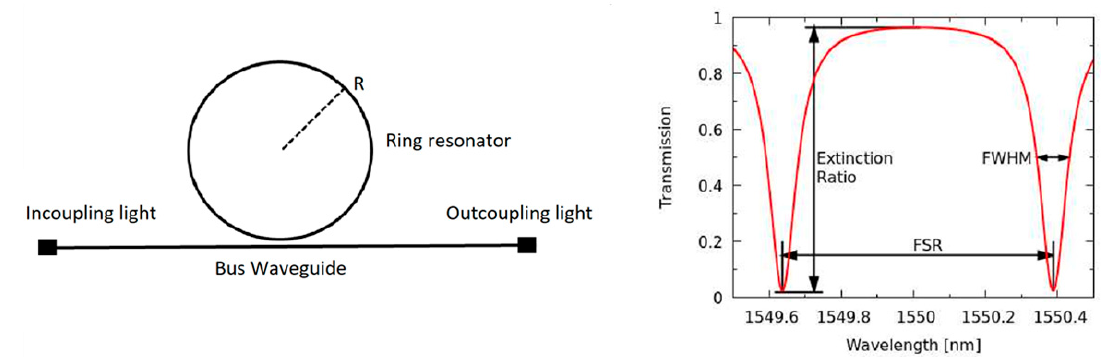
Figure 1. Schematic drawing of the principle of ring resonators and their generated transmission spectrum [8]. spectrum